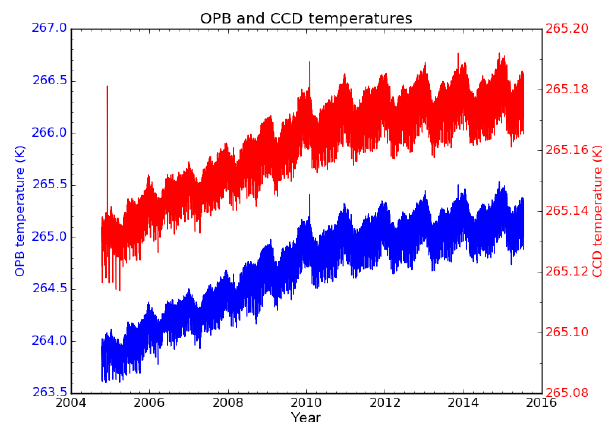
Figure 21. Changes in the OPB and the UV channel CCD tempera-